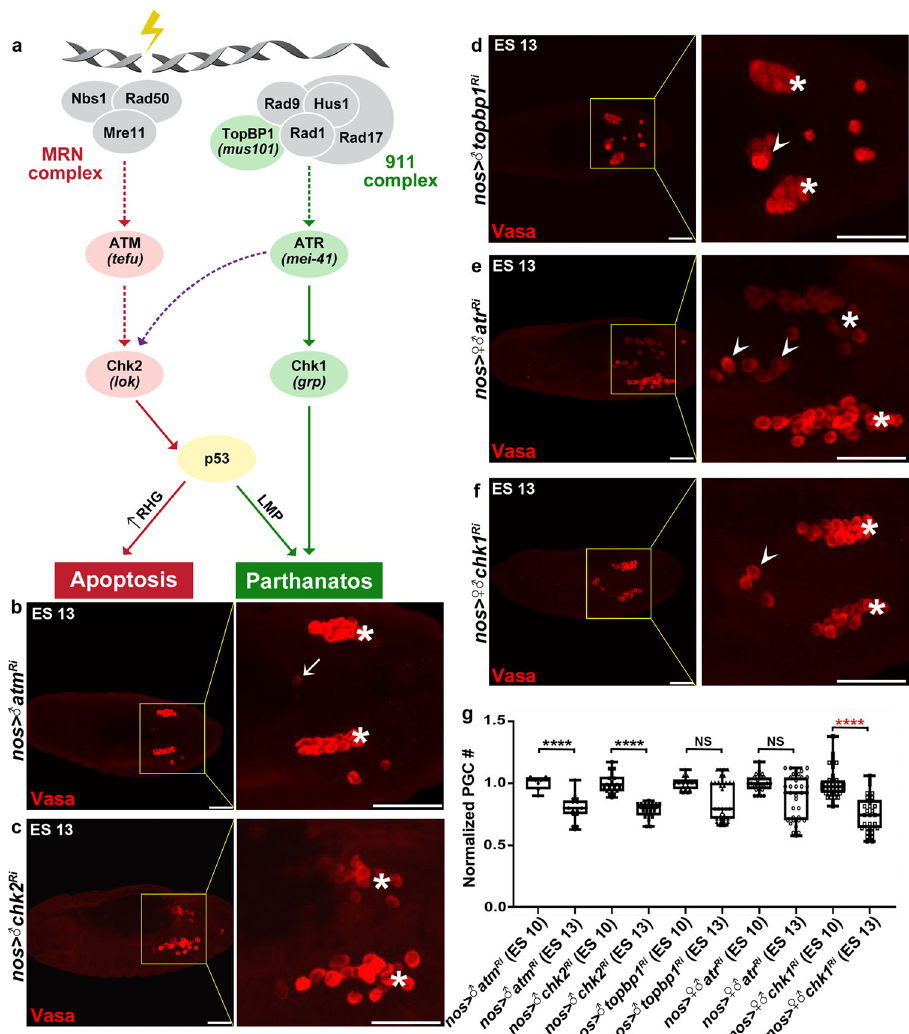
Fig. 6 Inactivation of the ATR/Chk1 branch of the DDR attenuates PGC death. a Illustration of the two branches of the DDR pathway induced by DNA damage. Tested components for effects on PGC death are indicated in pink (for no effect) and green (for having an effect). Untested/uncon fi rmed components are in gray. Dashed lines indicate suggested interactions based on data from mammalian systems or when direct regulation was not observed in Drosophila . In brackets are the names of the Drosophila genes if different from the names of the mammalian homologs. Note that for the sake of simplicity, only parthanatos is mentioned as a process downstream of Chk1. b – f Representative images of ES 13 embryos with PGC-speci fi c knockdowns of the indicated DDR pathway genes (corresponding to the cartoon model in a ), stained and presented as in Fig. 1b. PGCs (Vasa; red). Dying PGCs are indicated by arrows; ectopically surviving PGCs by arrowheads; gonadal PGCs by asterisks. Whereas PGC death normally proceeded upon knockdown of components in the ATM/Chk2 branch of the DDR ( b , c ), knockdown of components in the ATR/Chk1 branch of the DDR attenuated PGC death ( d – f ). Scale bars, 50 μ m. g Quanti fi cations of PGC death levels in embryos corresponding to the genotypes in ( b – f ). All data points, including outliers, were presented in box plot format where the minimum is the lowest data point represented by the lower whisker bound, the maximum is the highest data point represented by the upper whisker bound, and the center is the median. The lower box bound is the median of the lower half of the dataset while the upper box bound is the median of the upper half of the dataset. Each dot corresponds to the number of PGCs in a single embryo to re fl ect n number, where n = number of examined biologically independent embryos. **** p < 0.0001; NS, non-signi fi cant; Student ’ s t -test, one-sided distribution. Added information about the red asterisks is in the main (Supplementary Fig. 7e). This is consistent with a recent report suggesting that the (midline) subset of PGCs that undergo cell death is already predetermined at a very early stage of PGC speci fi cation, according to the levels of germplasm wunens they inherit from the oocyte, which in turn is determined by their spatial position at the posterior pole of the embryo 38 . In contrast to Hid OE induced PGC apoptosis, AIF and DNase II OE induced PGC death was non-apoptotic, as the dying PGCs were TUNEL negative and cell death was not attenuated by OE of the apoptotic inhibitors, Diap1 and Dronc DN (Supplementary Fig. 7f – h).